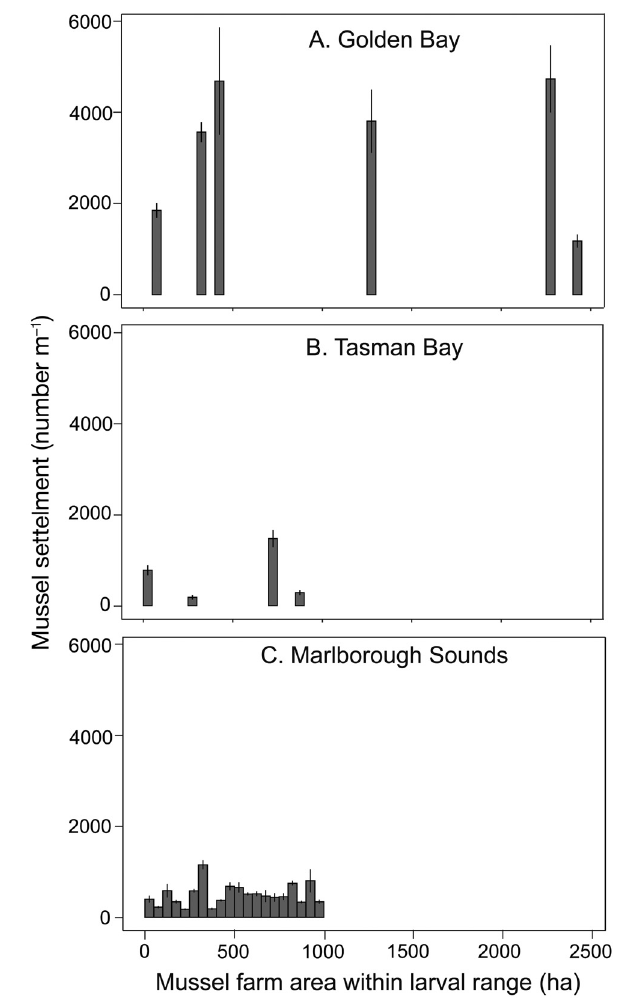
Fig. 4. Mean mussel settlement and corresponding total ex- tent of nearby mussel aquaculture. Mean green-lipped mus- sel settlement per metre of sampling rope (n = 16563) from 1974 to 2020 in (A) Golden Bay, (B) Tasman Bay, and (C) the Marlborough Sounds compared with total area of mussel aquaculture within the estimated larval dispersal distance for each study area (25 km of the sampling location for Golden Bay and Tasman Bay or 10 km for the Marlborough Sounds). Error bars show